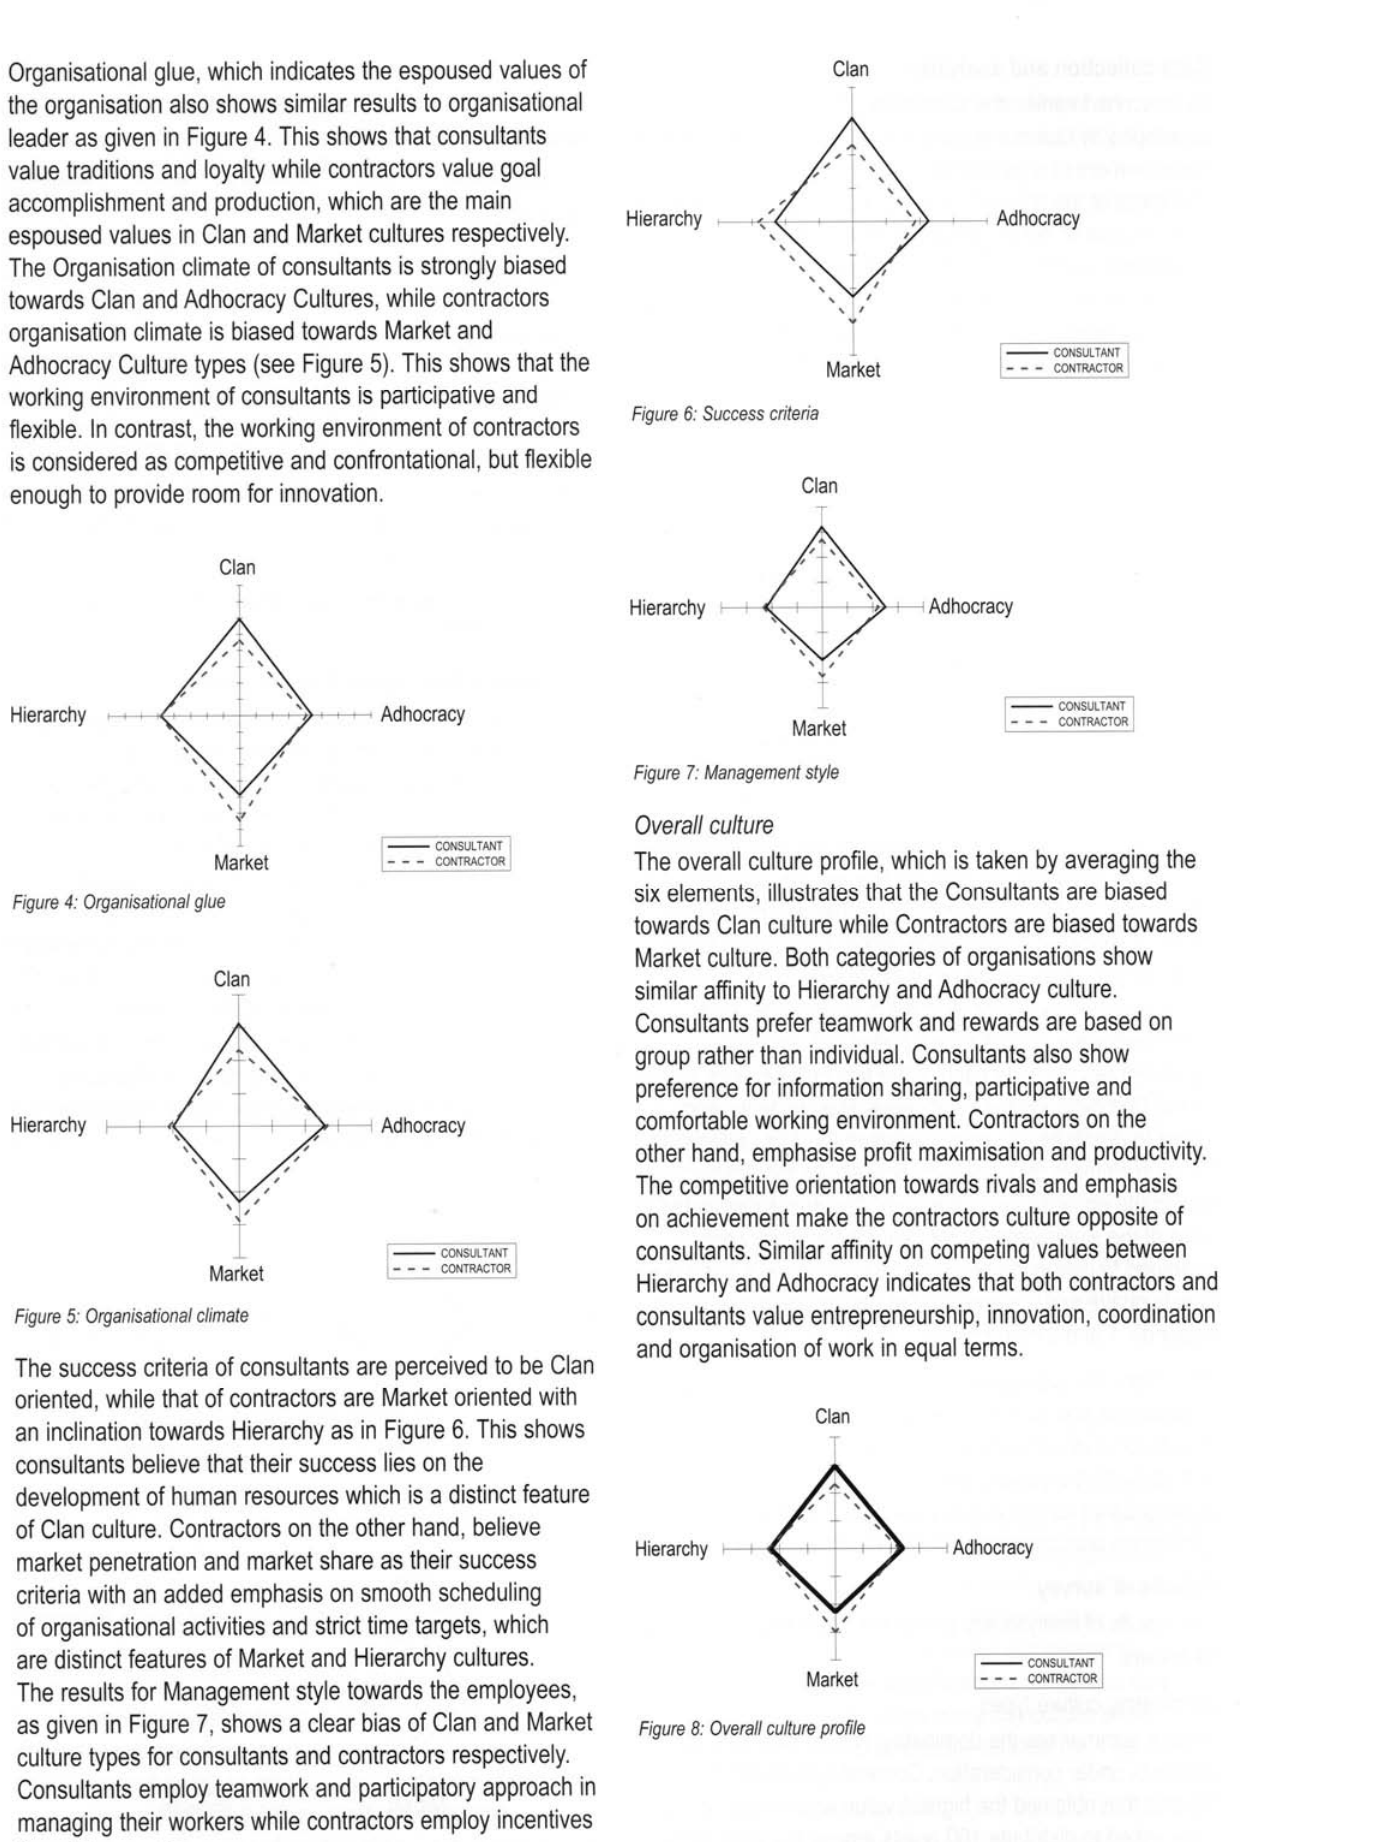
Figure 8: Overall culture